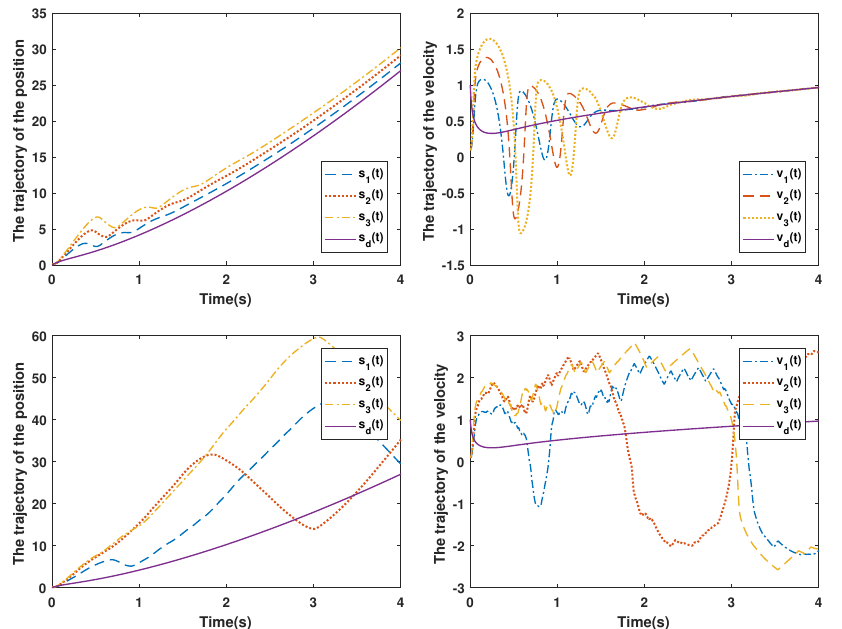
Figure 3. The trajectories of the position and velocity of the vehicular platoon system between the proposed method ( up ) and the method in [13] ( down ).